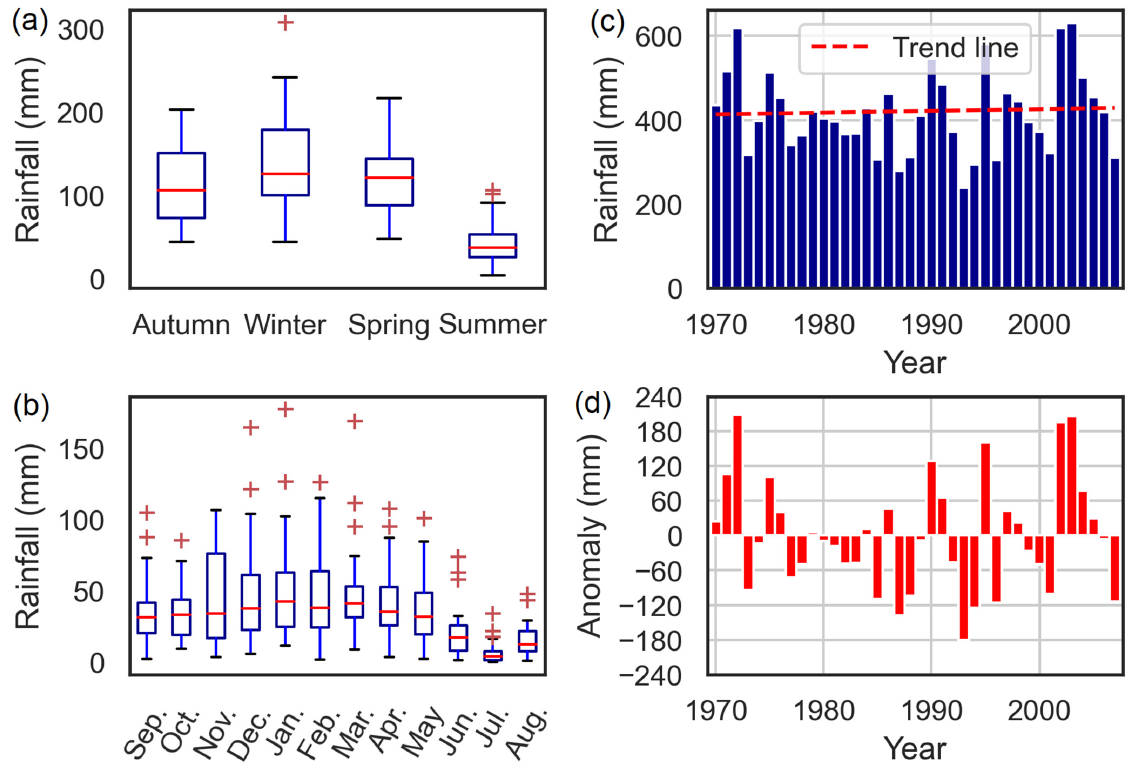
Figure 4. Rainfall variability represented by box plot at ( a ) seasonal and ( b ) monthly scales, and histograms of ( c ) the average annual rainfall and ( d ) the annual rainfall anomaly.